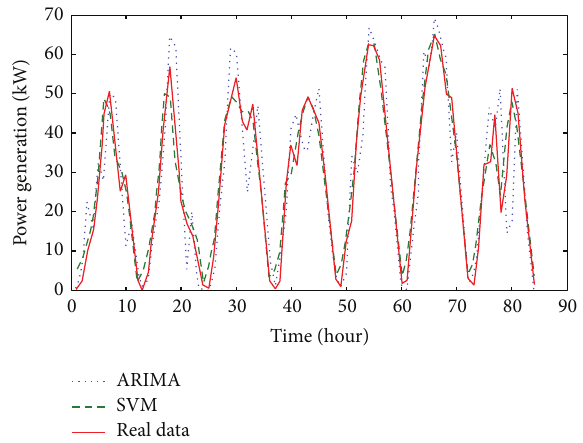
Figure 9: Forecasting resultsfor PVpower at NPU by using ARIMA and SVM.